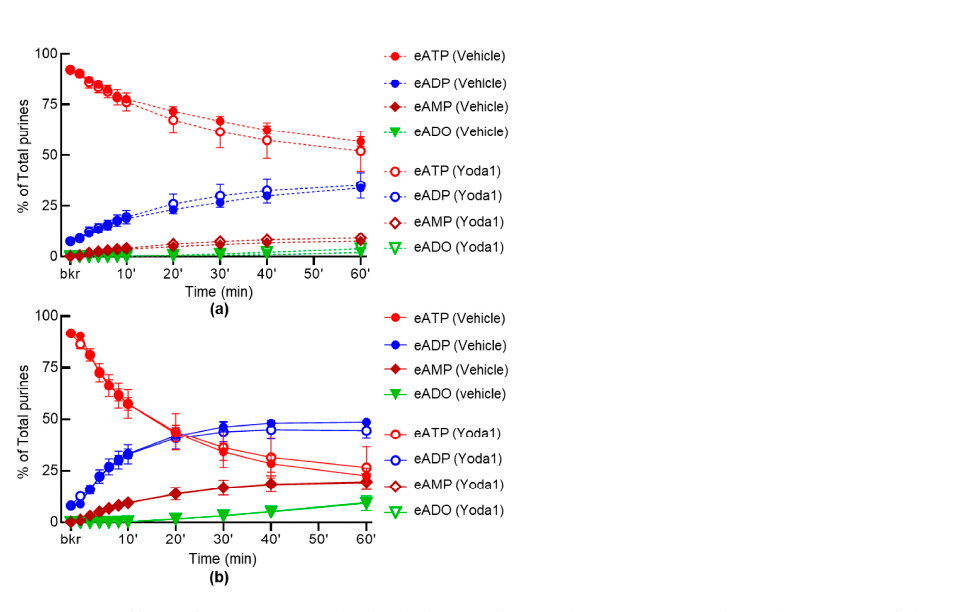
Figure 5. E ff ect of YODA1 on the hydrolysis of eATP by s-ENTDs released in cELS of detrusor- free bladder preparations. Changes in eATP, eADP, eAMP and eADO in the presence of vehicle (DMSO 0.2%, n = 6) or Yoda1, 40 µM ( n = 5) in nondistended ( a ) and distended ( b ) bladder prepara- tions; n , number of bladder preparations. eATP, eADP, eAMP and eADO are presented as percent- ages of total purines (eATP + eADP + eAMP + eADO) present in reaction solutions. p > 0.05 at all time-points of reaction. Two-way ANOVA with Sidak’s multiple comparisons tests. 2.5. Inhibition of TRPC1 and TRPC6 Channels Have Weak E ff ect on the Spontaneous and